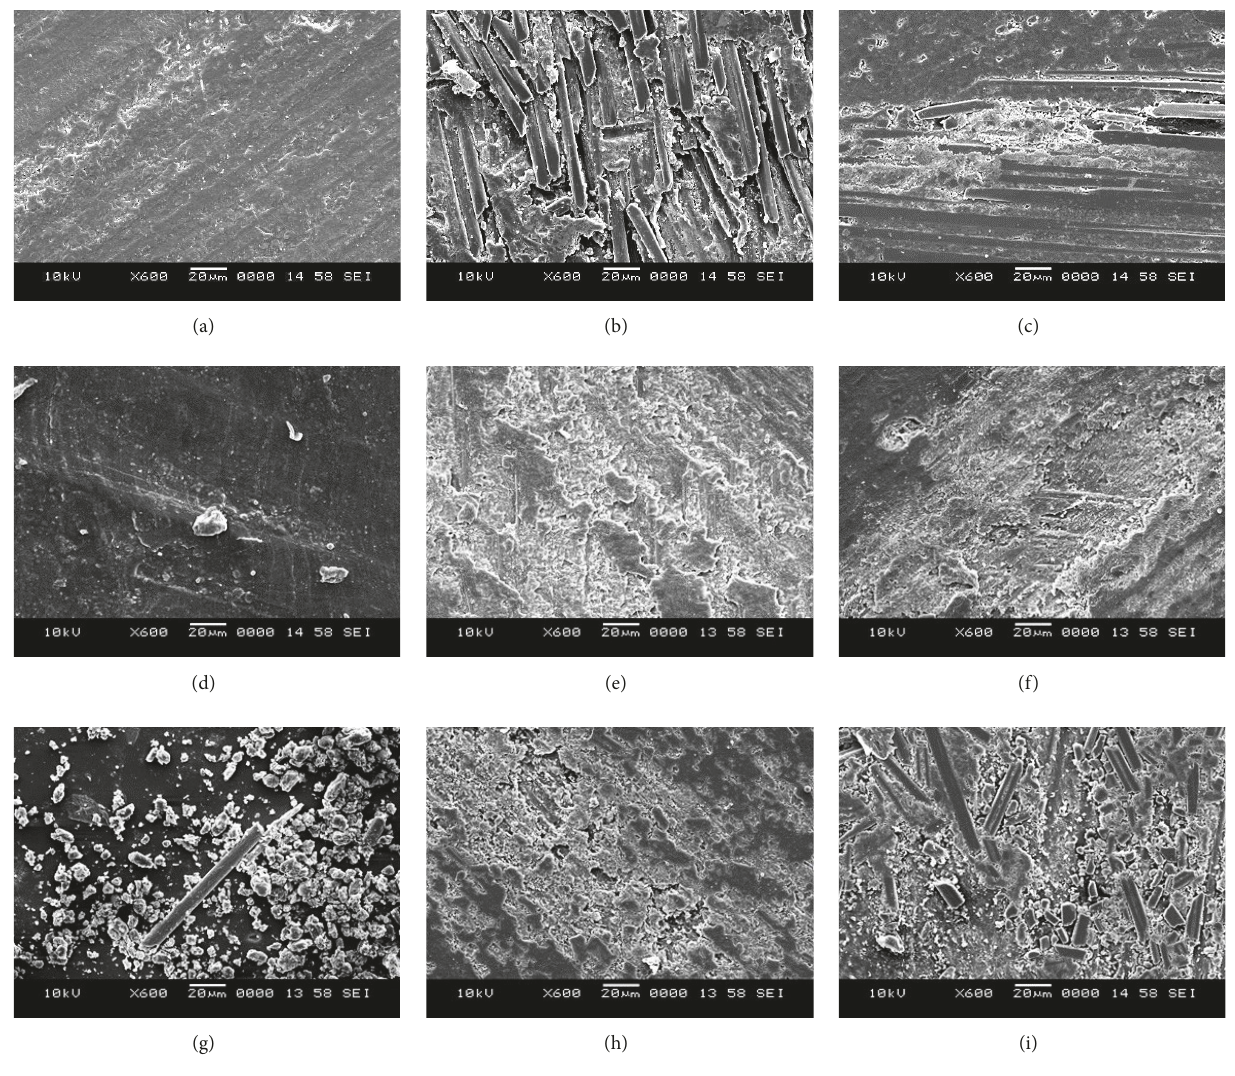
Figure 8: SEM images of worn-out surface of CF/E composites at different loads and speeds (a) 15 N, 1.5 m. s −1 (b) 30 N, 1.5 m. s −1 (c) 45